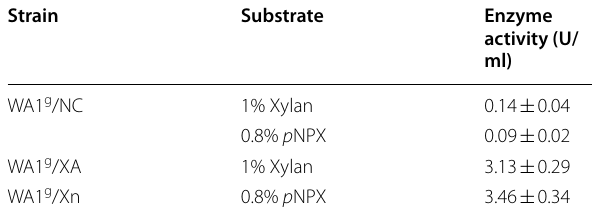
Table 3 Enzyme activities of xylanases Strain